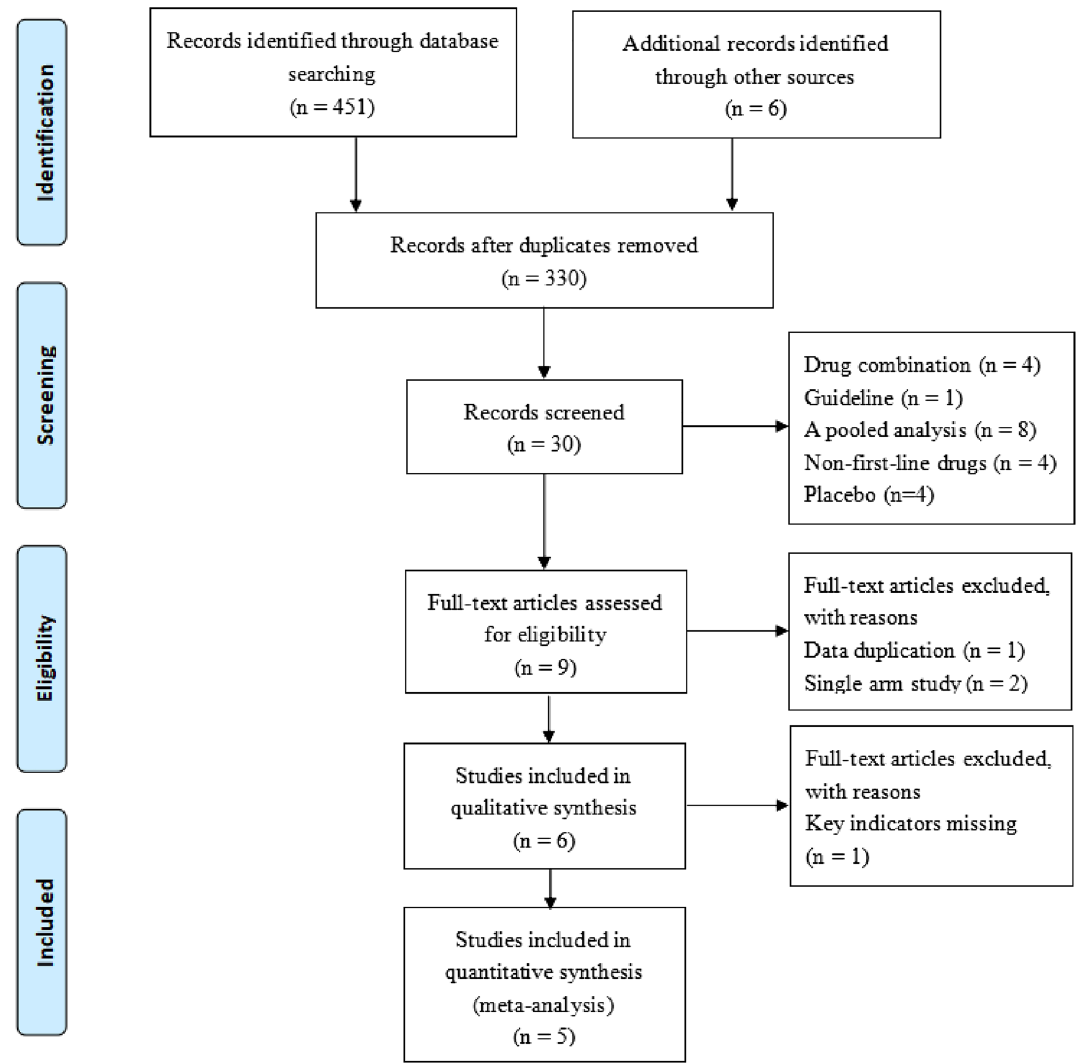
Figure 1. Flow diagram of studies searched in this meta-analysis.